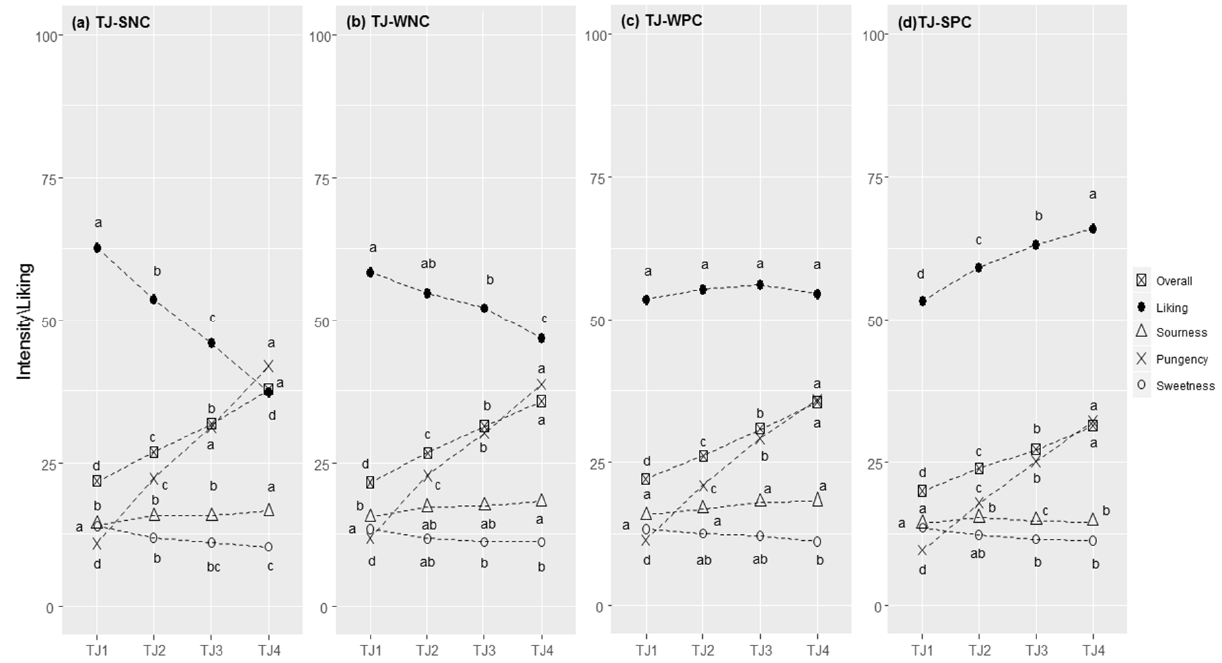
Figure 5. Tomato juice (TJ) responses in each cluster (SNC = Strong Negative Correlation ( a ), WNC = Weak Negative Correlation ( b ), WPC = Weak Positive Correlation ( c ), and SPC = Strong Positive Correlation ( d )): perceived intensity (gLM scale) and liking (LAM scale) for samples at increasing concentrations of capsaicin (1–4). Within each cluster, different letters indicate significant differences in intensity/liking between concentration levels ( p <